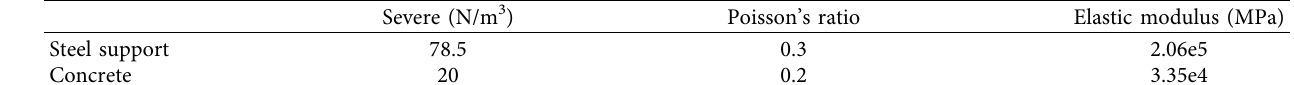
Table 3: Other material calculation parameters.